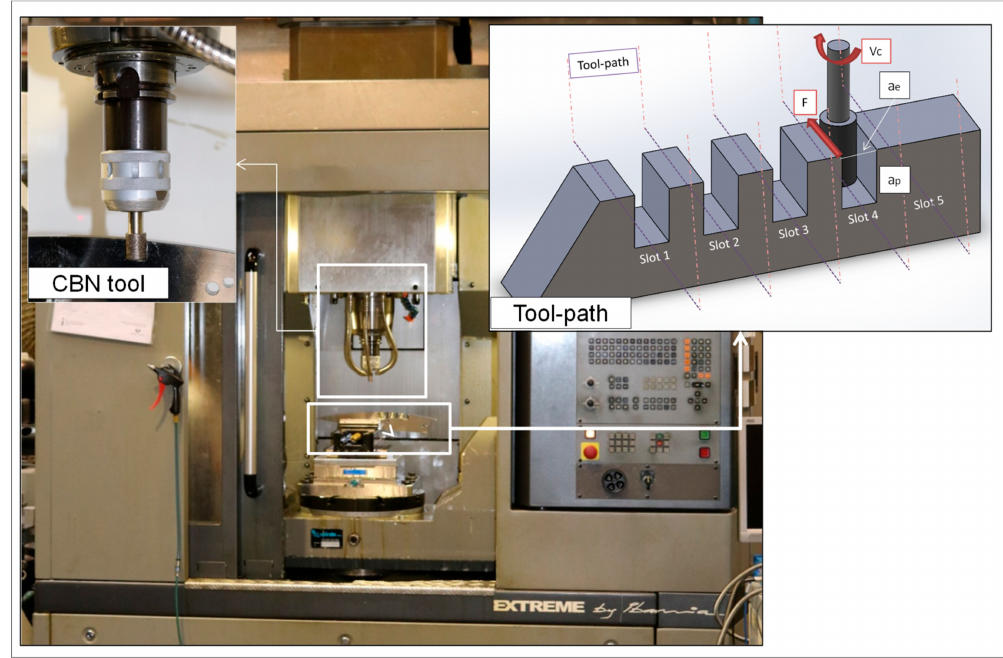
Figure 3. Experimental setup at the University of the Basque Country